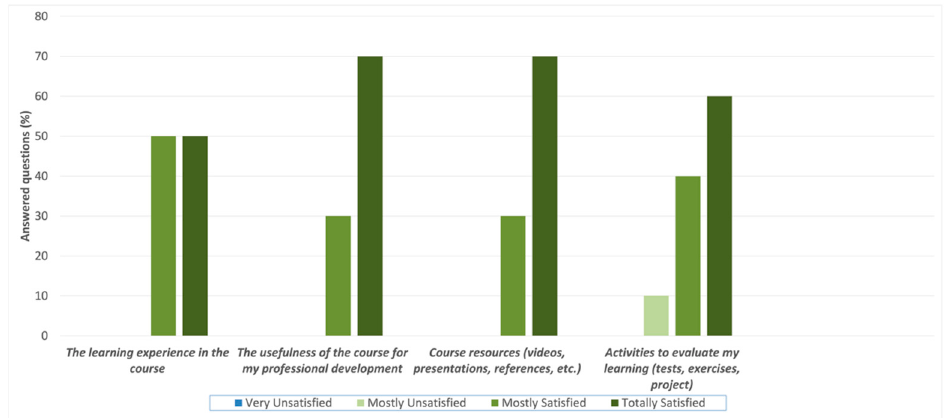
Figure 4. Participant’s answers to Question #3—“Indicate your general level of satisfaction with the following course elements.”